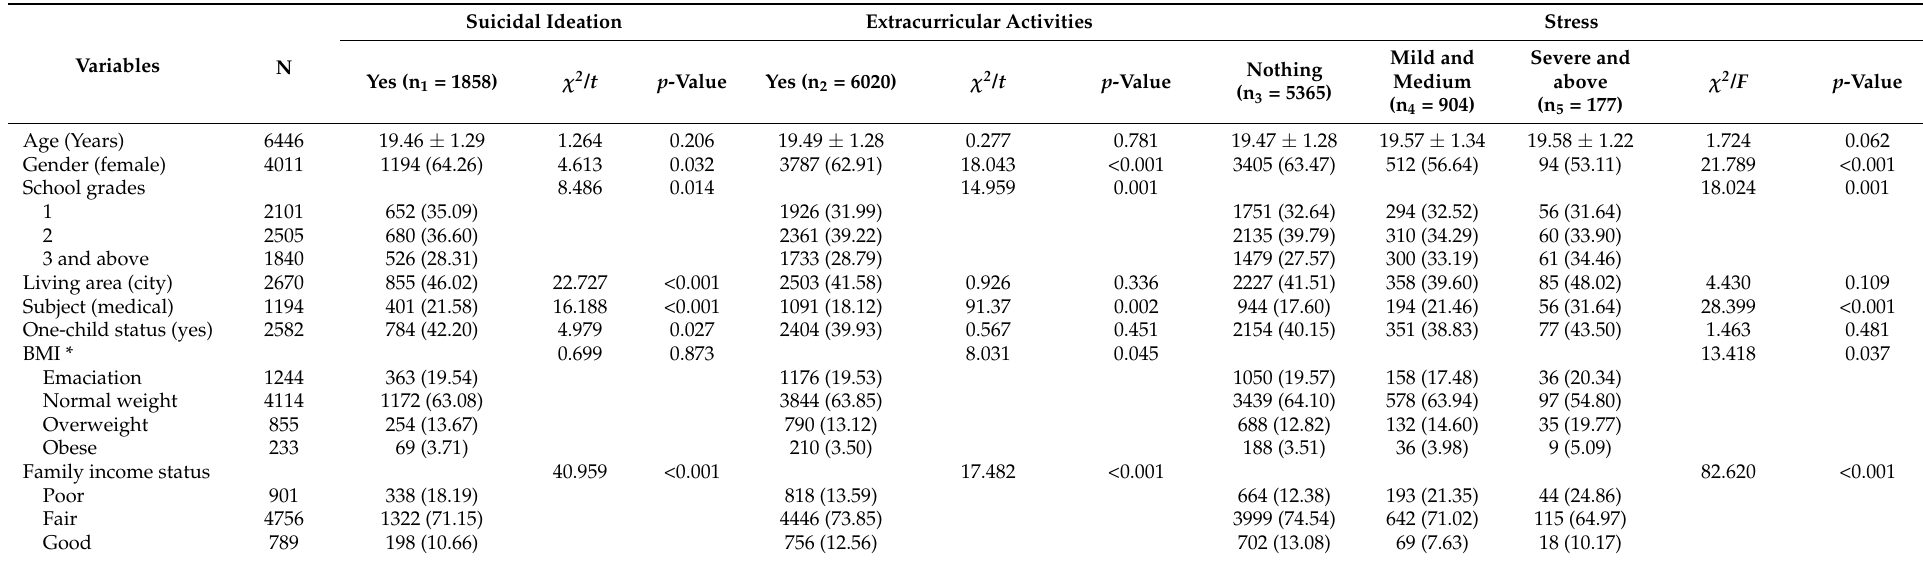
Table 1. Demographic comparison of suicidal ideation [mean (SD), n